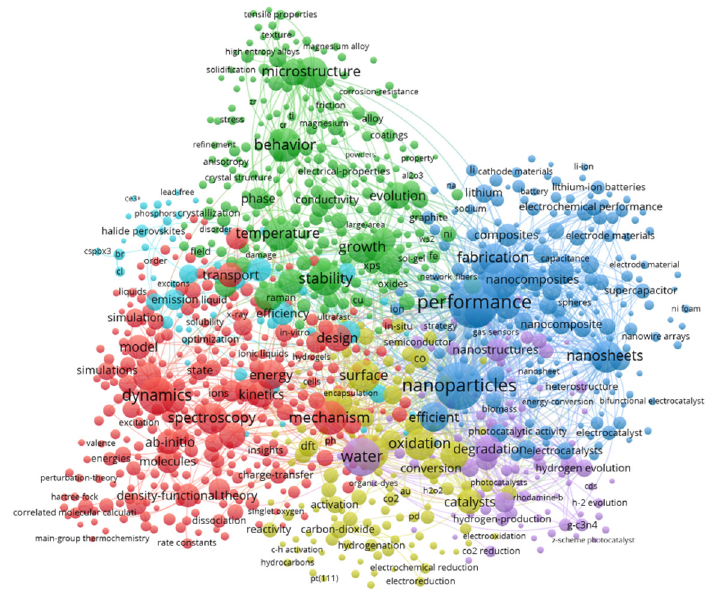
Figure 1. Incidence rate of keywords in PhysChem articles in the categories of Physical Chemistry and Chemical Physics published in 2018–2021.